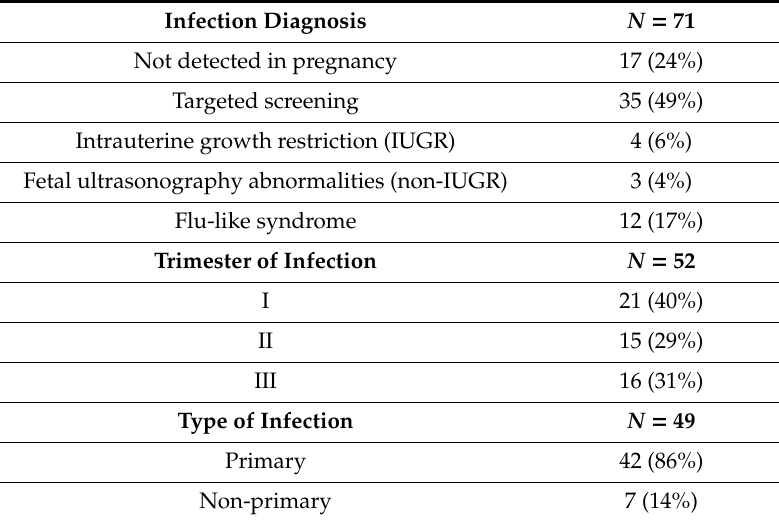
Table 2. Characteristic of maternal infection.